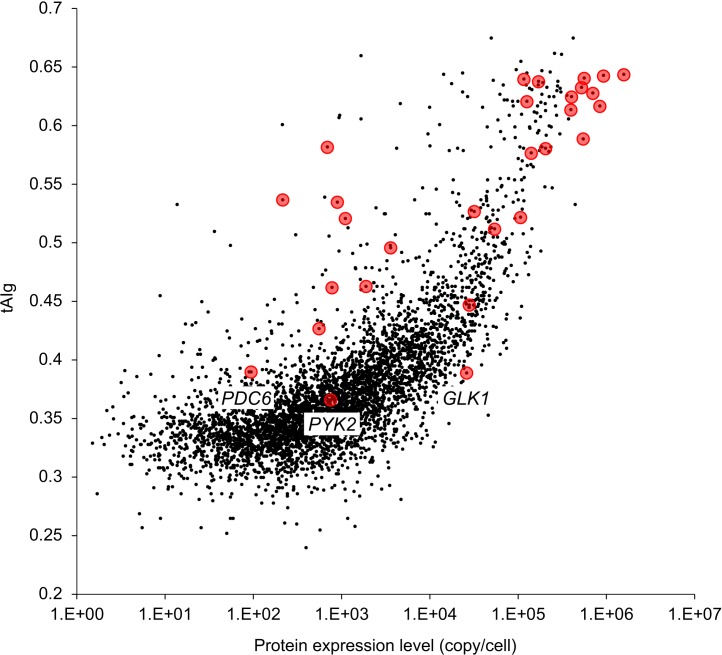
Scatter plot showing the tAIg and native expression level of S. cerevisiae protein.The tAIg was calculated on the basis of the method described by Tuller et al. (2010). For the native expression level of S. cerevisiae protein, a published dataset was used (Kulak et al., 2014). Red points indicate glycolytic genes/proteins that are analyzed in this study. The tAIgs of all yeast proteins are listed in Figure 6—source data 1.